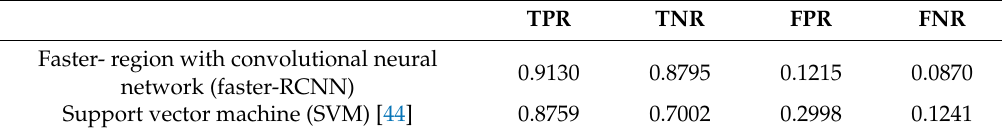
Table 2. Performance measurements for cyclones detection results using two di ff erent